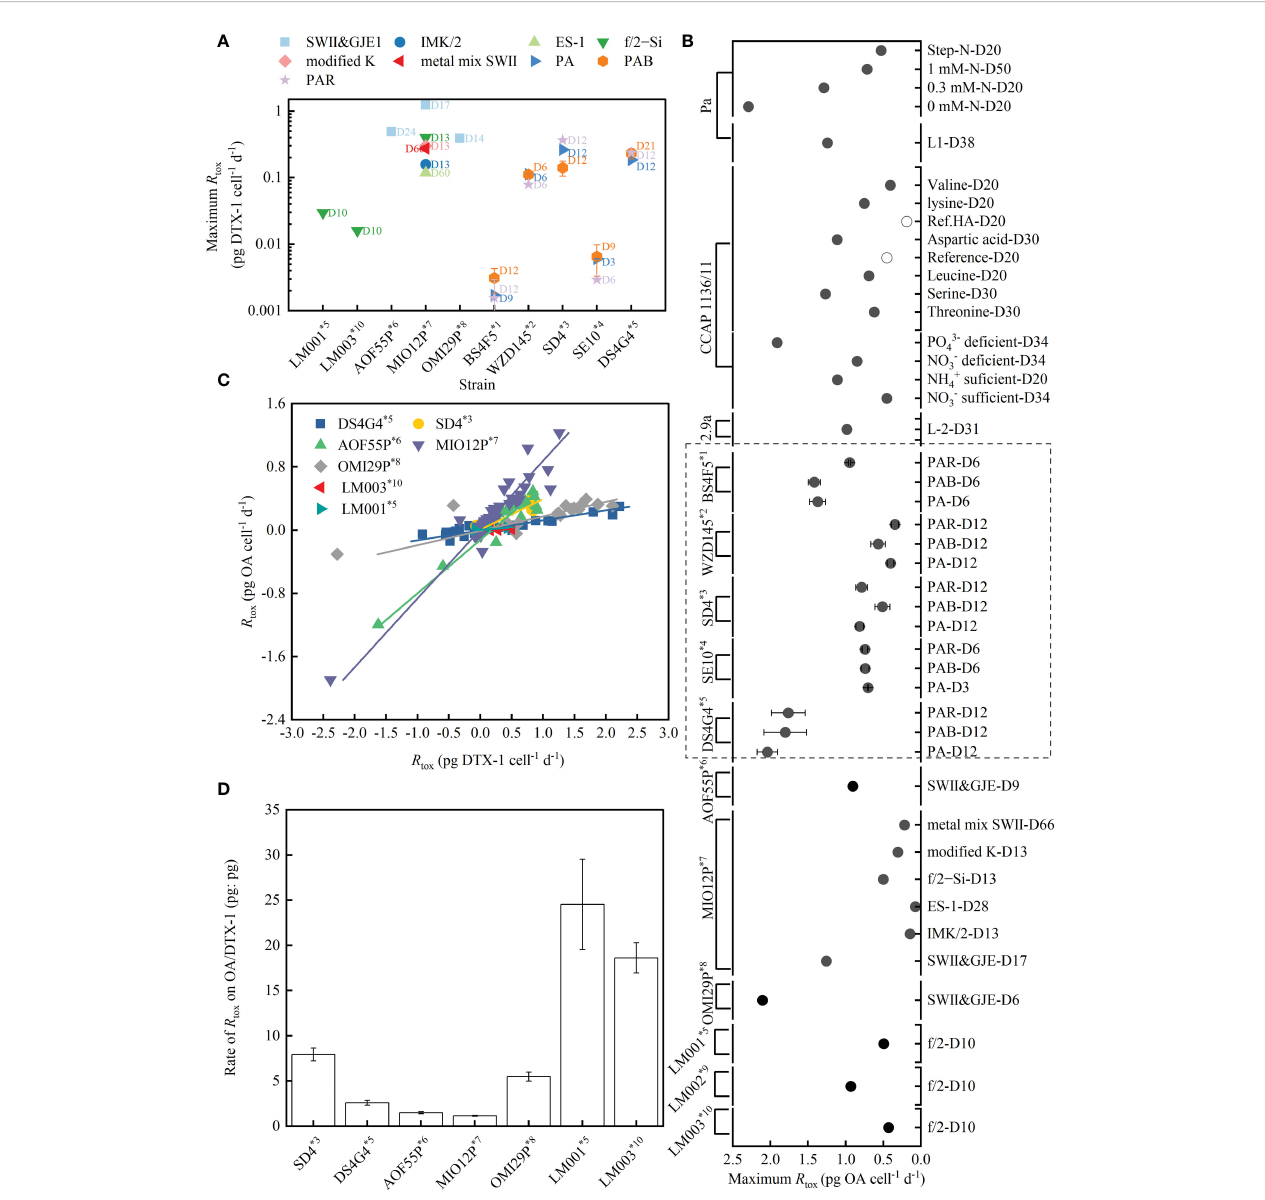
FIGURE 4 Maximum toxin production rate ( R tox ) of DTX-1 (A) and OA (B) under different treatments (the day is denoted by D) from various strains of the P. lima complex and P. caipirignum (strain SE10). Linear relationships between the R tox of OA and DTX-1 in speci fi c strains with a maximum DTX-1 production rate above 0.01 pg cell -1 d -1 , except for strain WZD145 (C) . The ratio of R tox of OA/DTX-1 (pg: pg) varied with strains (D) . Data for strain Pa from (McLachlan et al., 1994; Pan et al., 1999), strain CCAP 1136/11 (also known as strain PL2V) from (Souto et al., 2001; Varkitzi et al., 2010), strain 2.9a